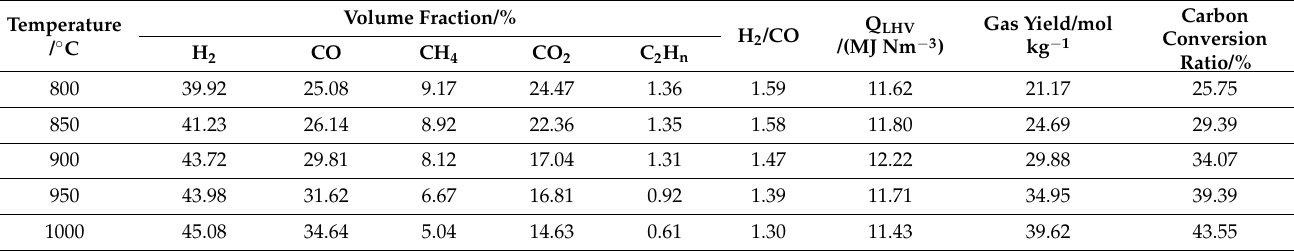
Table 3. Effect of temperature on the gas characteristics